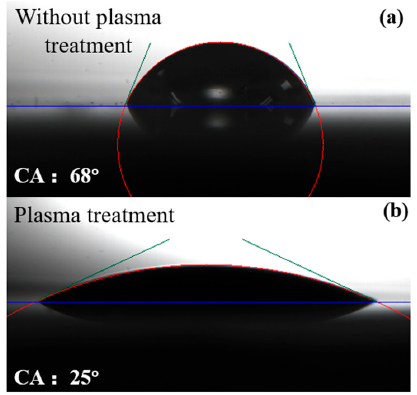
Figure 5. Measurement results of contact angle. ( a ) The contact angle between PET and liquid GAP without plasma treatment, which was about 68°; ( b ) The contact angle between PET and liquid GAP with plasma treatment, which was about 25°. with plasma treatment, which was about 25 ◦